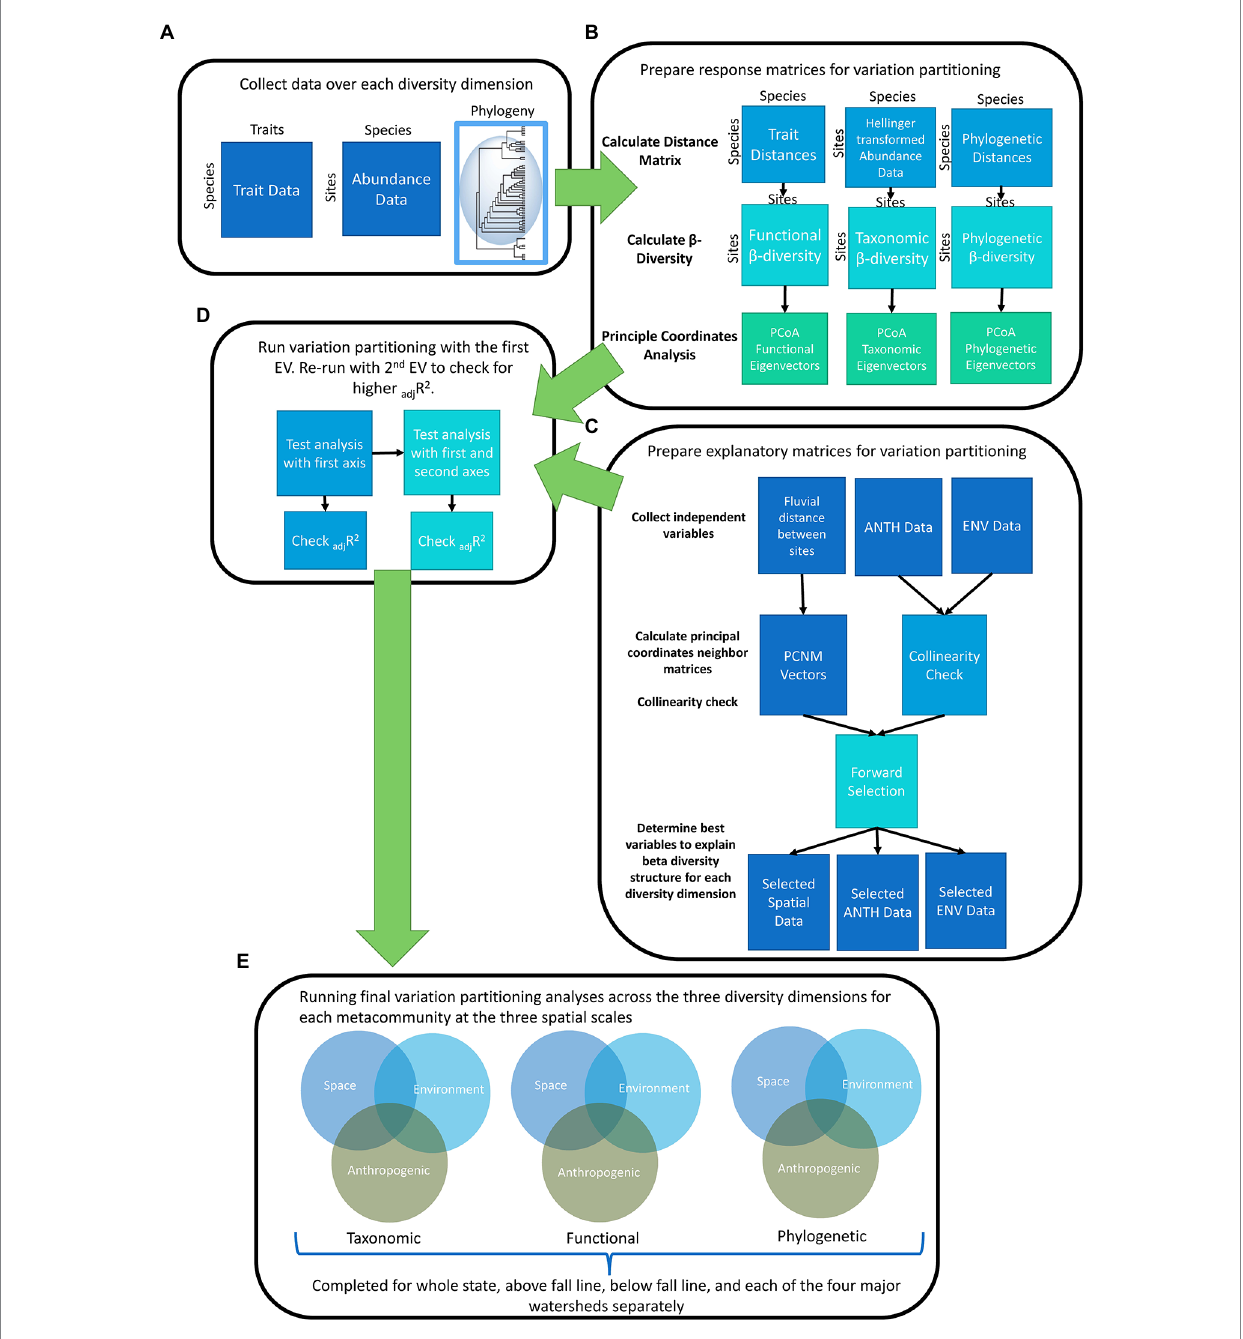
FIGURE 2 Flowchart for statistical analysis completed by collection of stream fish abundance data (A) , preparation of response (B) and explanatory matrices (C) , preparation for variation partitioning (D) , and final variation partitioning run (E) over our spatial delineations and diversity dimensions. ANTH, anthropogenic; ENV, Natural Environmental; PCNM, Principal coordinate neighbor matrices; EV, Environmental